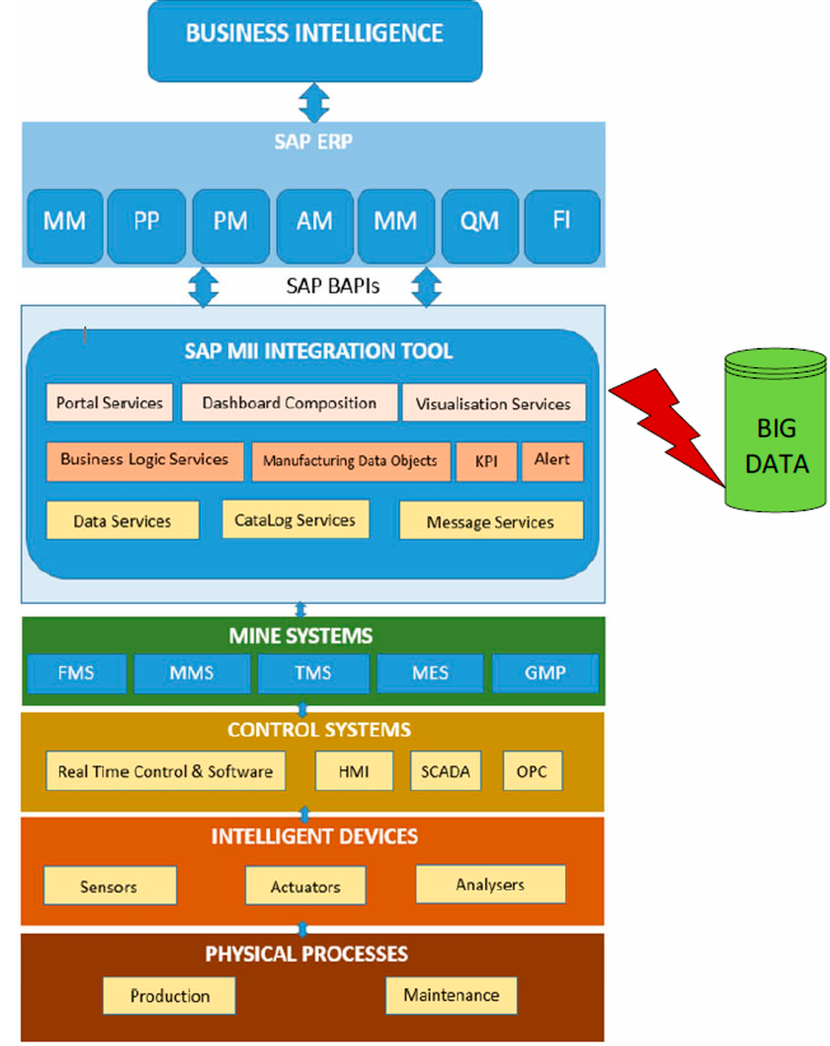
Figure 6. Implementation of Industry 4.0 technologies in the mining industry (Reprinted from Ref. [45]). Ref.